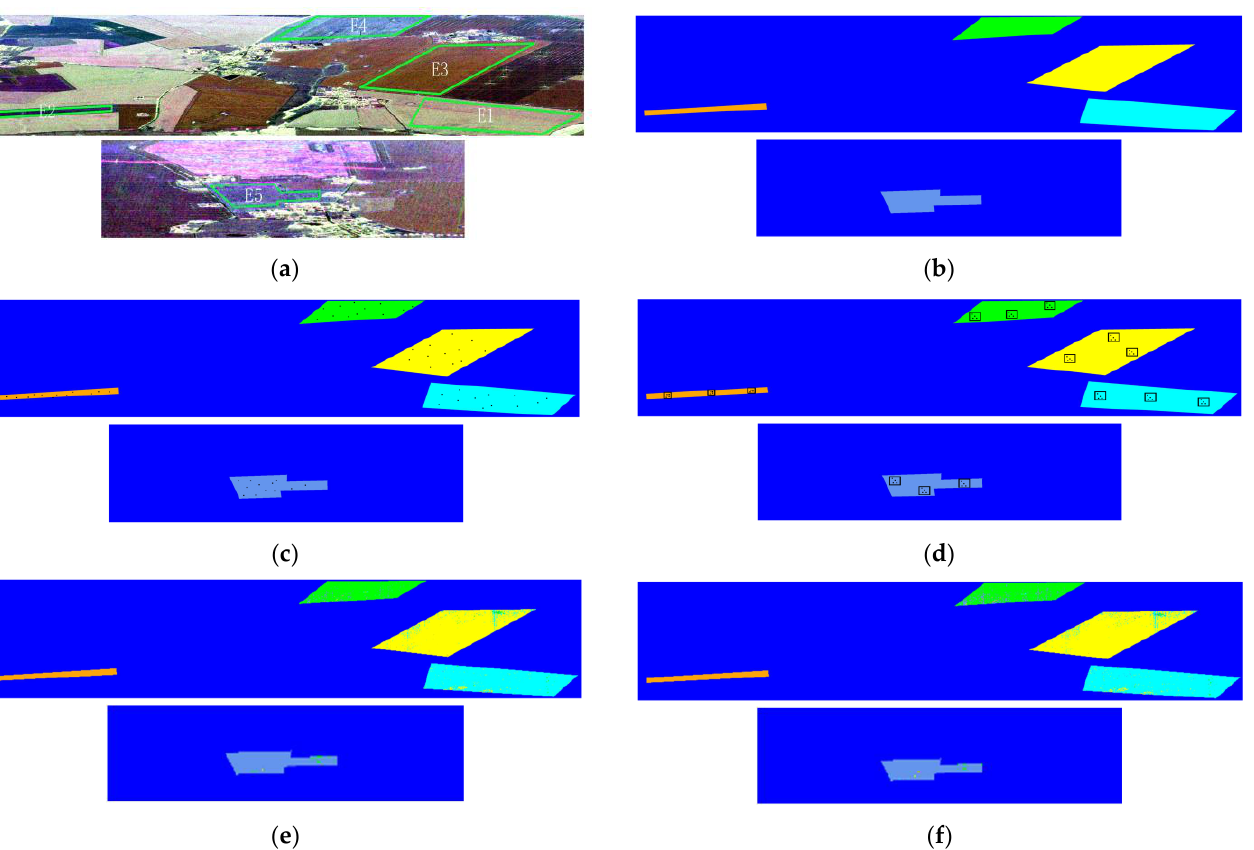
Table 8. Comparison between random sampling and spatially disjoint sampling on the field dataset.